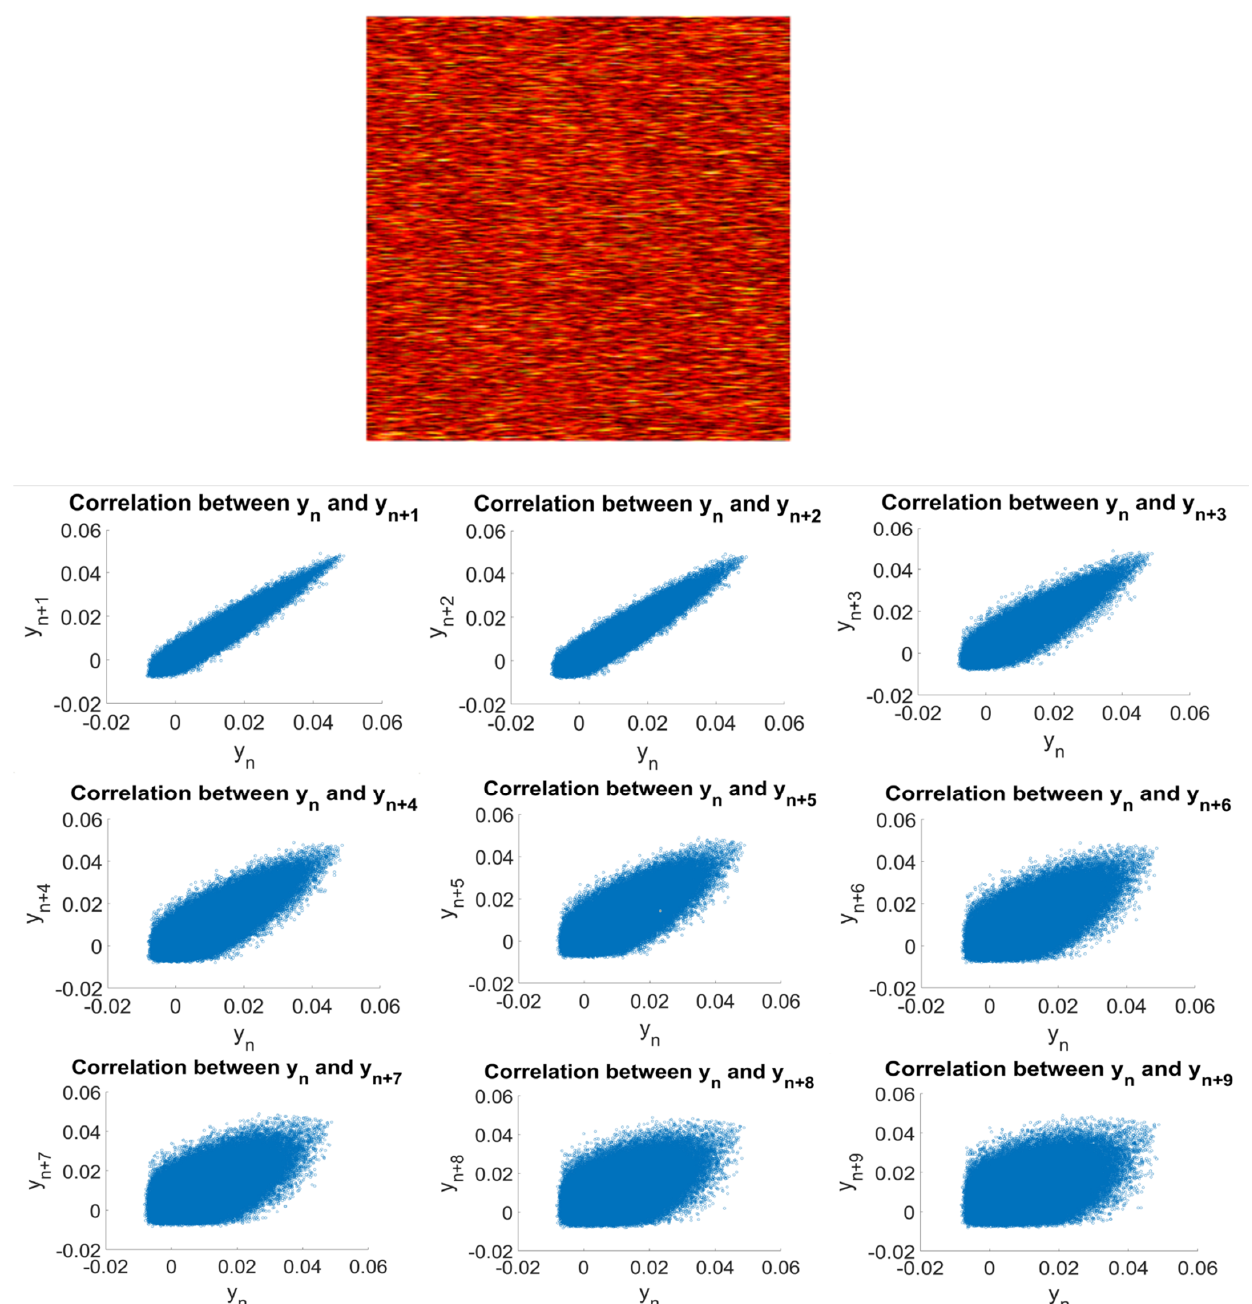
Figure 6. Scatter plots of two pixels along the fast axis. In each plot, y _ n is the value of a pixel at column n . The image was acquired with an acquisition time of 8